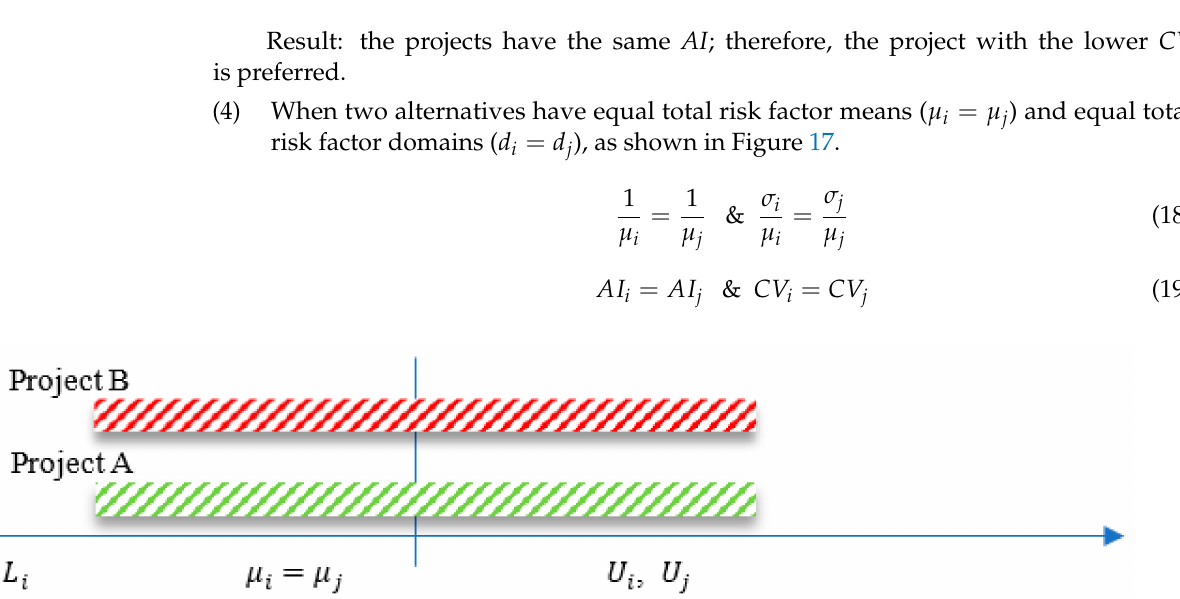
Figure 16. Possible condition one: similar means and different domain lengths.